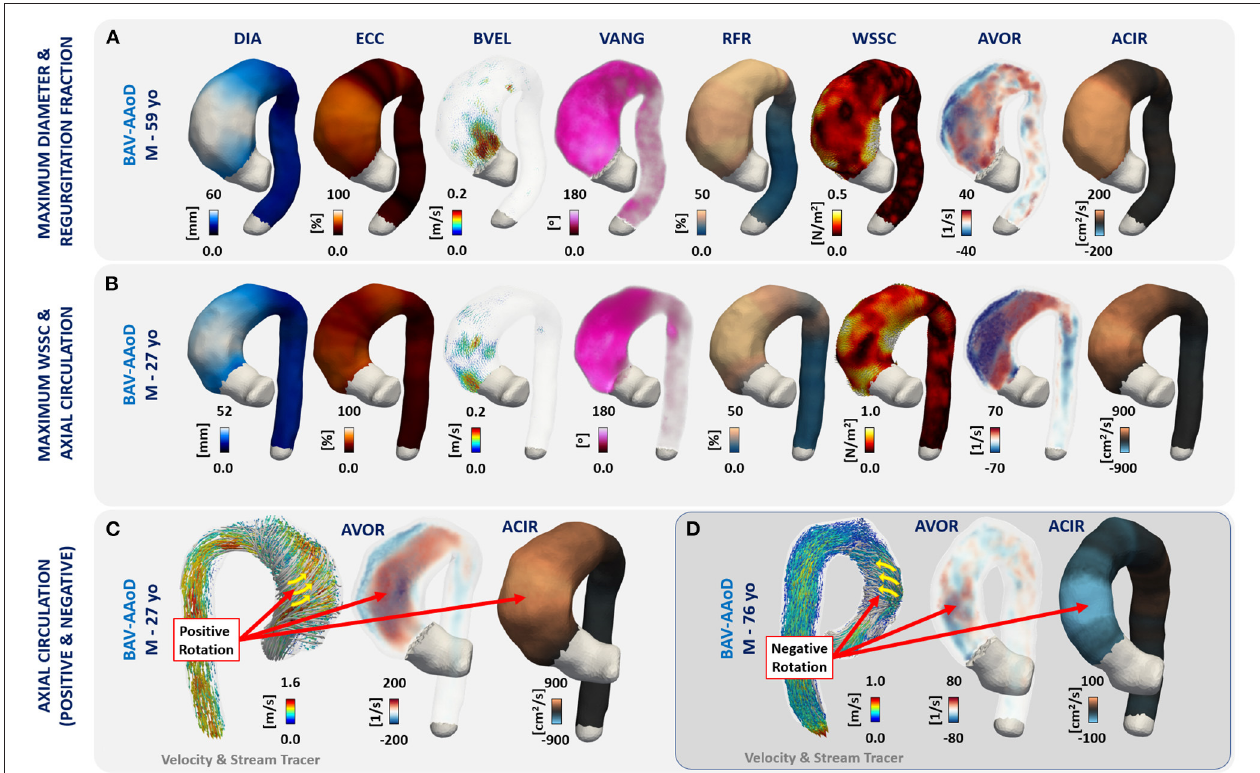
FIGURE 6 | (A) A patient with maximum values of diameter and regurgitation fraction; (B) a patient with maximum WSS C and axial circulation; (C) a patient with positive axial circulation; and (D) one case with negative axial